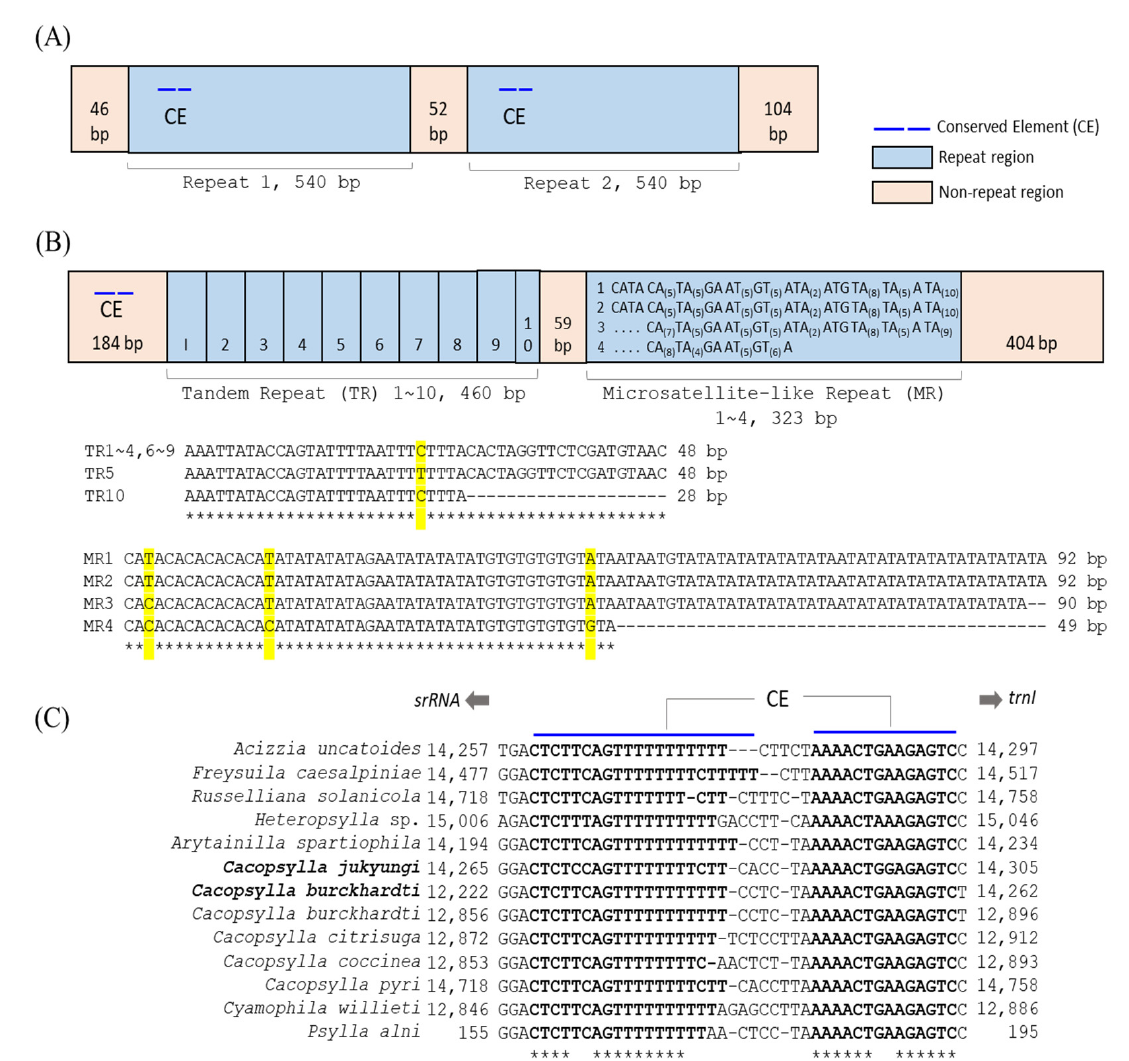
Figure 2. Schematic map of the two longest A+T-rich regions detected in Psyllidae species. ( A ) Cacopsylla jukyungi (this study). ( B ) Russelliana solanicola (Percy et al., 2018). Yellow boxes, copies with substitutions. ( C ) An alignment of a conserved element (CE) detected in the A+T-rich region of Psyllidae. The arrows indicate the transcriptional direction of the neighboring two genes. *, consensus sequences.